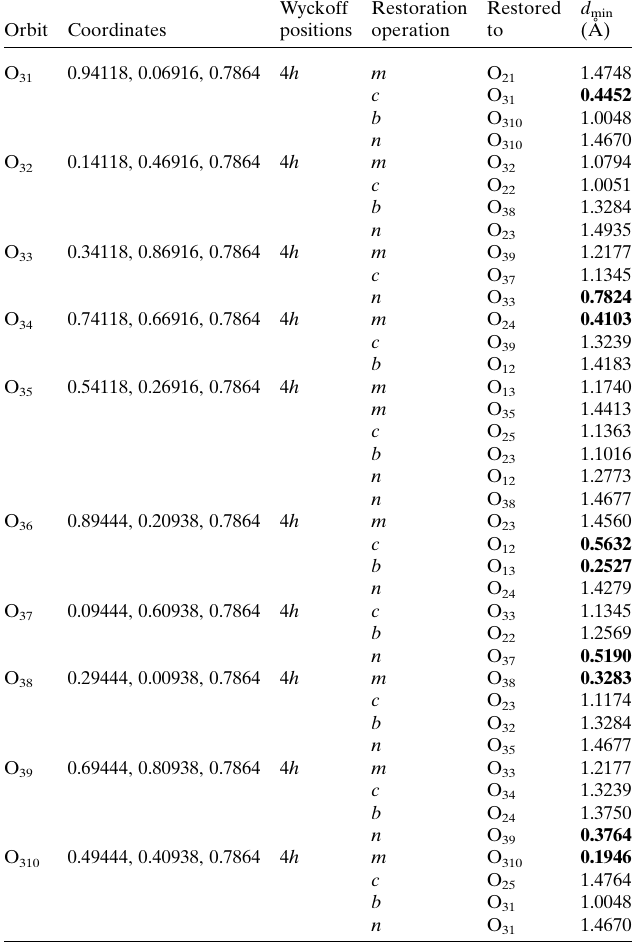
Table 8 Analysis of the split orbits O 3 j stemming from O 3 under H = P (cid:2) 44. Same conventions as in Table